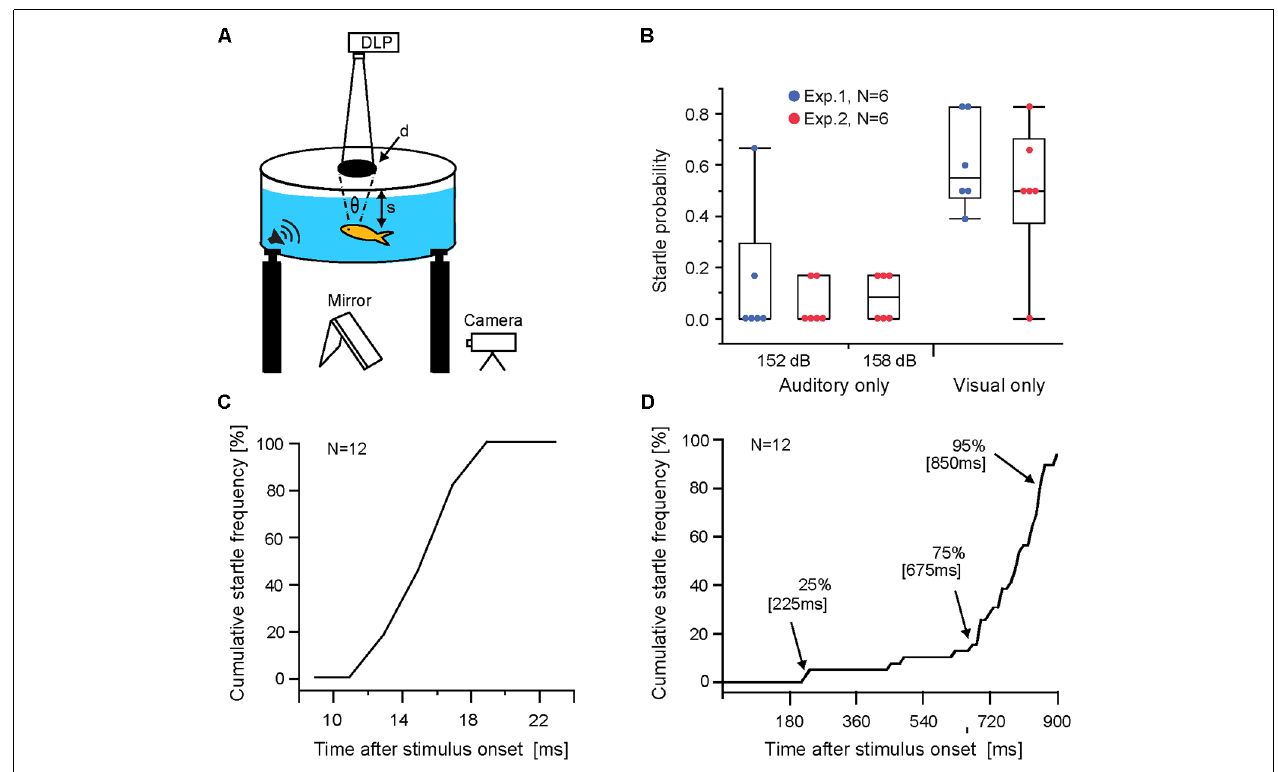
FIGURE 1 | Auditory and visual evoked Mauthner-cell (M-cell) startle responses. (A) Schematic of behavioral setup. Visual loom stimuli were projected onto the translucent lid of the experimental tank and sound pips were delivered through underwater loudspeakers ( θ indicates subtended view angle, d is the diameter of the projected disk, and s is the distance from the lid to the fish). (B) Boxplots of startle probabilities to unimodal auditory and visual stimuli used in Exp 1 and 2. Dots indicate data of individual fish. (C) Line graph plotting sound evoked cumulative startle frequency vs. response latency for all audio stimuli trials (152 dB and 158 dB re 1 µ Pa in water). (D) Line graph plotting visual evoked cumulative startle frequency vs. response latency. Arrows indicate time points when audio stimuli were triggered in multimodal paradigms. Note: startle escape probabilities increase dynamically during the loom, with most responses occurring between 80% and 95% loom